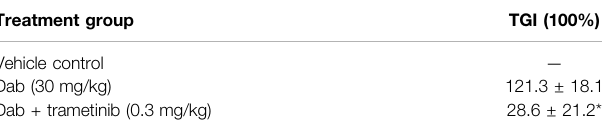
TABLE 1 | TGI comparison for combination of Braf inhibitor Dabrafenib and MEK inhibitor trametinib in Vem-resistant VR1 xenograft